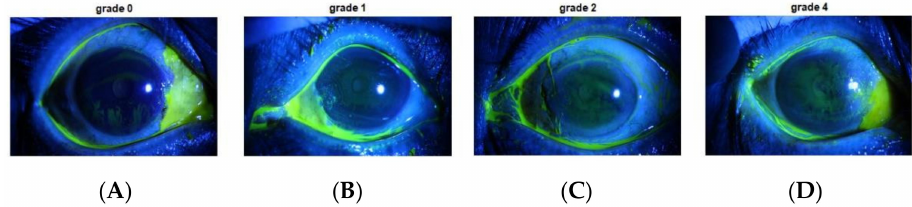
Figure 3. ( A ) Grade 0, ( B ) Grade 1, ( C ) Grade 2, and ( D ) Grade 4. Figure 4 represents the classes of type grade.